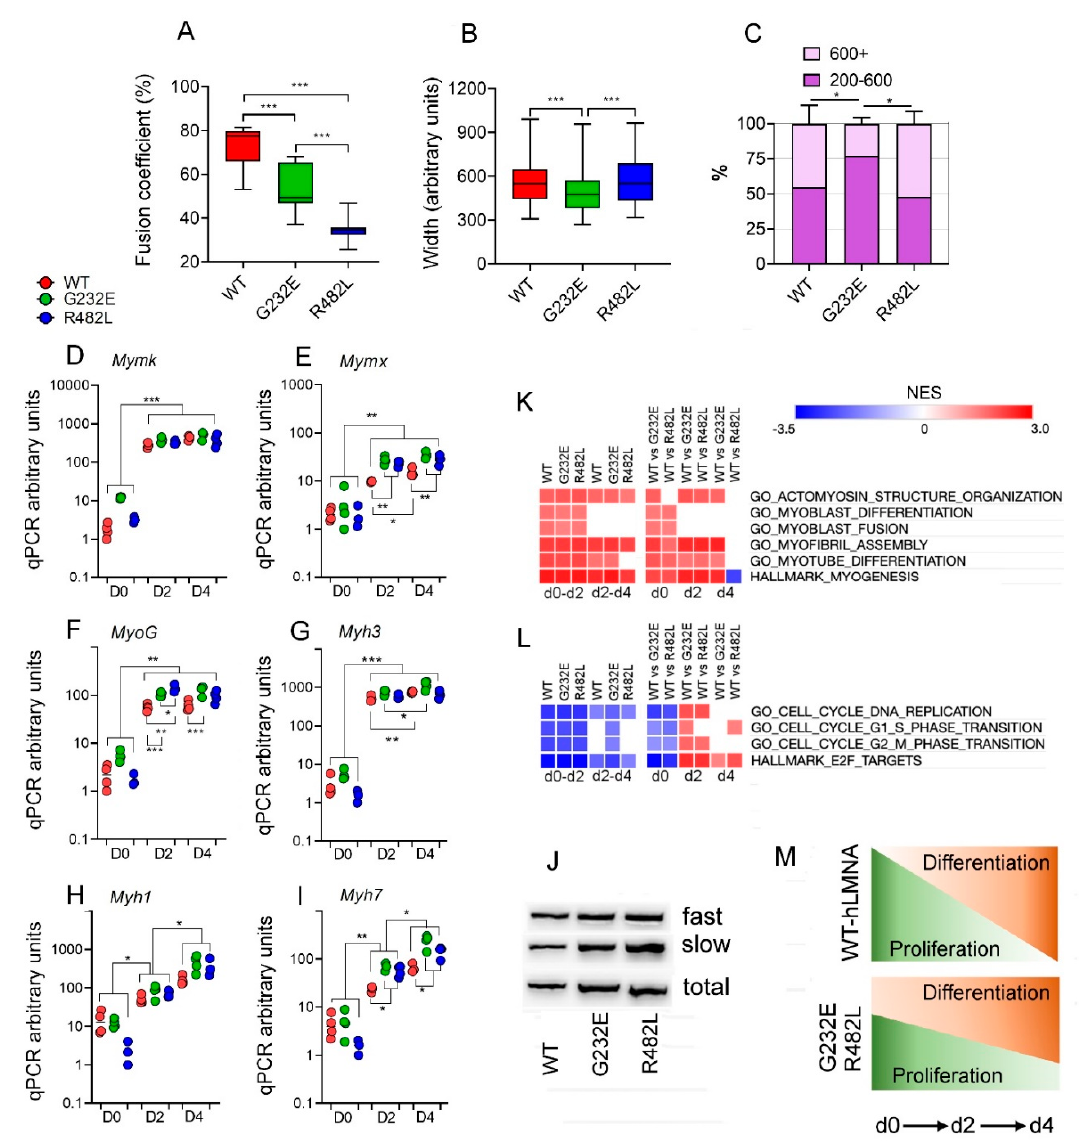
Figure 3. Myogenesis in transgene cultures. ( A ) Fusion coefficient calculated as a percent of nuclei incorporated in differentiated myotube in independent photographs; n = 8; *** p < 0.001, t -test; ( B ) width of myotubes, measured in arbitrary units in 5–6 independent photographs; the number of myotubes on each photo was 10–20; *** p < 0.001, t -test; floating bars are shown with mean, minimum and maximum values; ( C ) diagram illustrate the fractions of “massive” and “overage” myotubes in cultures; * p < 0.05; ( D – F ) The mRNA expression dynamics of genes that regulate myoblast fusion ( Mymk , Mymx ) and of myogenic regulatory factor Myog ( n = 4; mean + SEM; * p < 0.05; ** p < 0.01; *** p < 0.001; Mann–Whitney test); ( G – I ) the mRNA expression dynamics of fiber-specific genes: fast ( n = 4, mean + SEM, * p < 0.05; ** p < 0.01; Mann–Whitney test). ( J ) Western blotting analysis for total